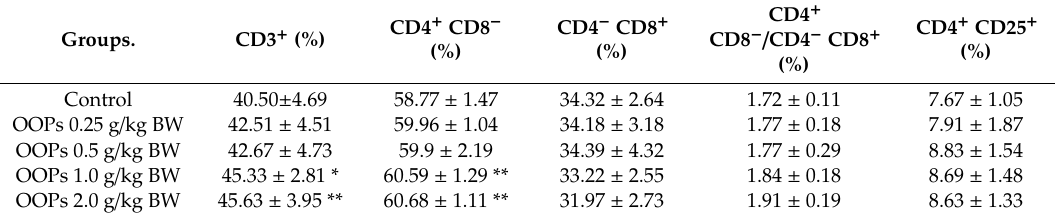
Table 3. E ff ects of OOPs on splenic T lymphocyte subpopulations.